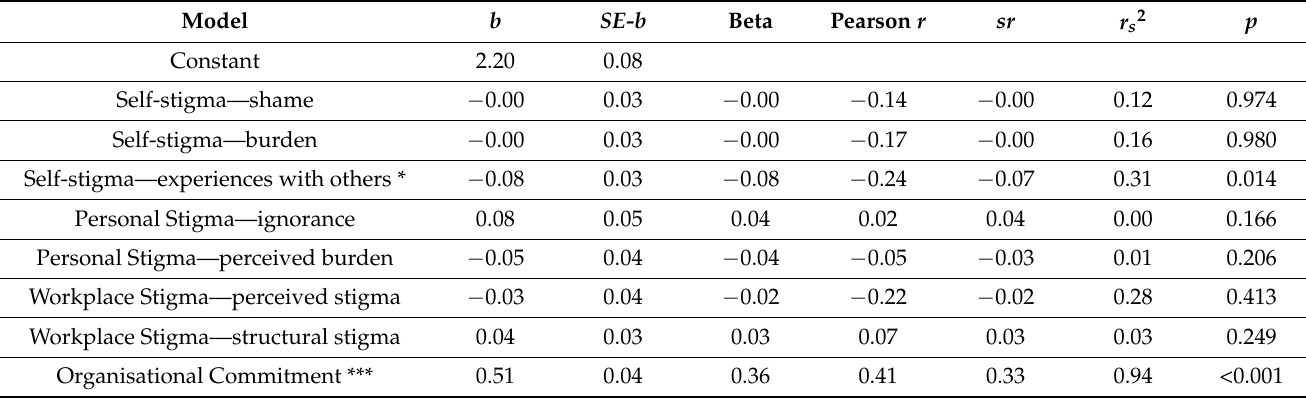
Table 6. Standard Multiple Regression Results for Self-stigma, Personal Stigma, and Workplace Stigma Predicting How Supportive a Police and Emergency Service Personnel Found their Claims Process for Psychological